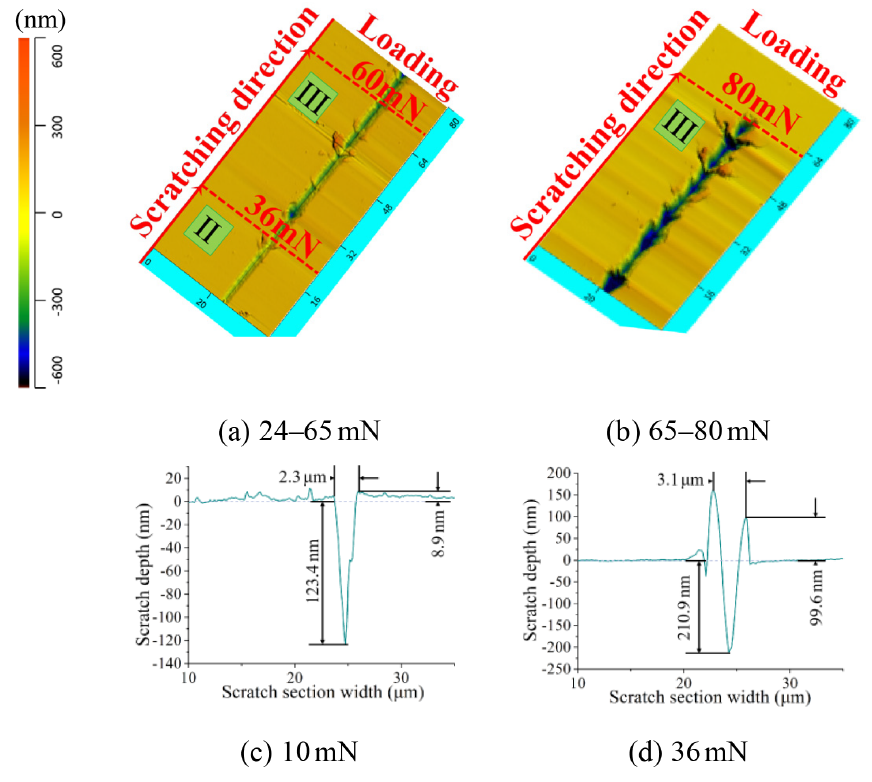
Figure 7. AFM analysis of the Si scratching sample.